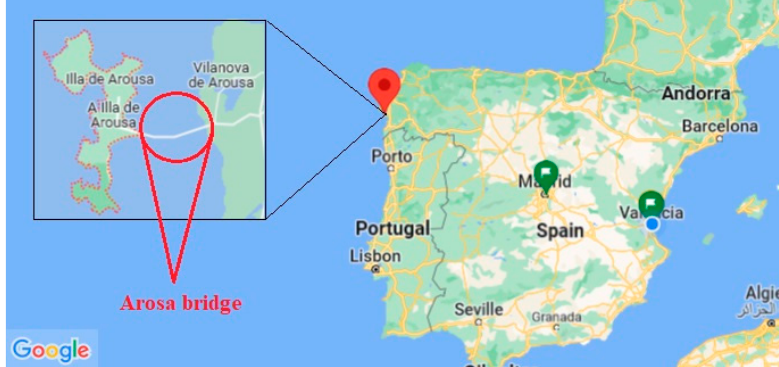
Figure 1. The location map of the Arosa bridge in Spain.